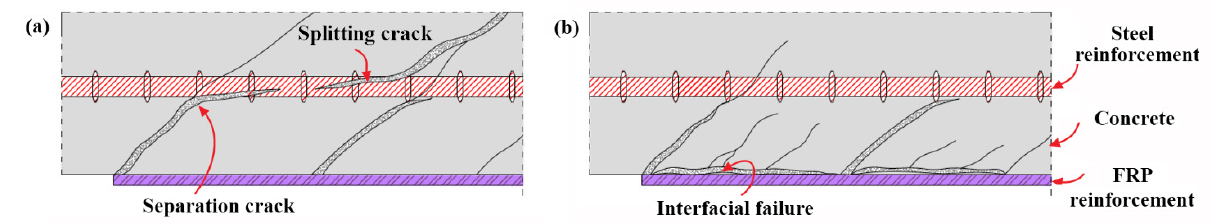
Figure 3. Schematical crack configurations: ( a ) cover separation; and ( b ) interfacial debonding.